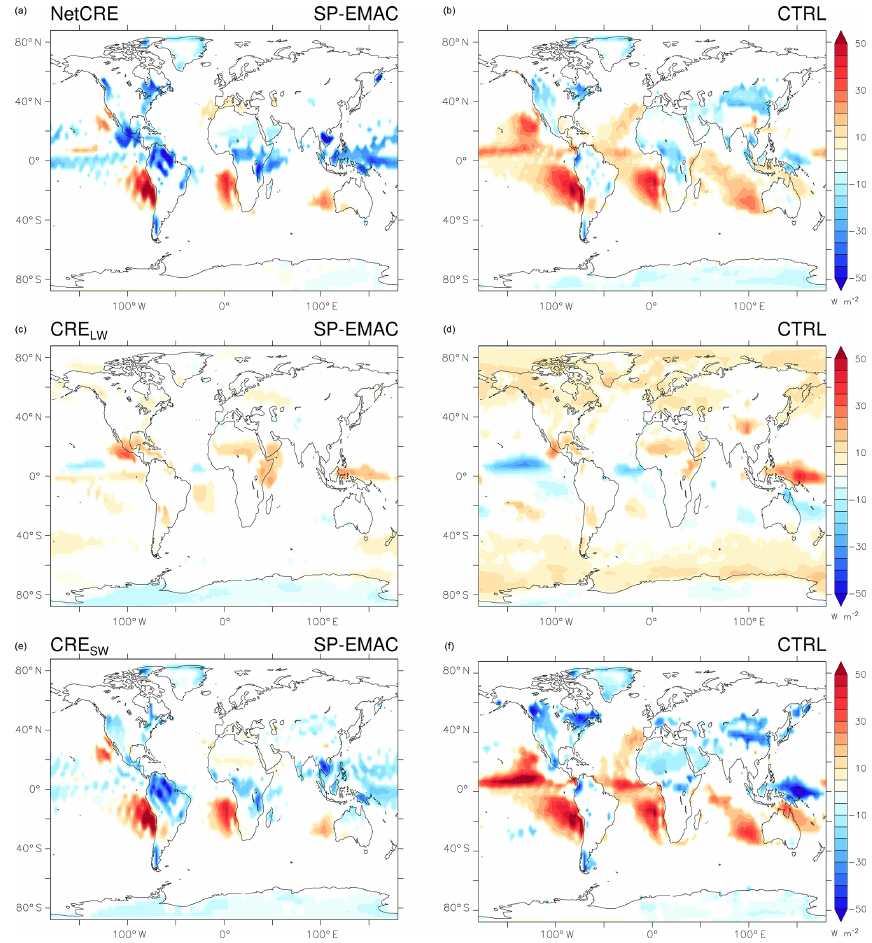
Figure 8. Differences in simulated and observed cloud radiative effects at TOA: net (a, b) , longwave (c, d) and shortwave (e, f) . Results for SP-EMAC ensemble (a, c, e) and CTRL (b, d, f) are shown compared to global observations (CERES). Coloured areas show only regions with significant differences in cloud radiative effects (analysed with t tests on a significance level of 90%).